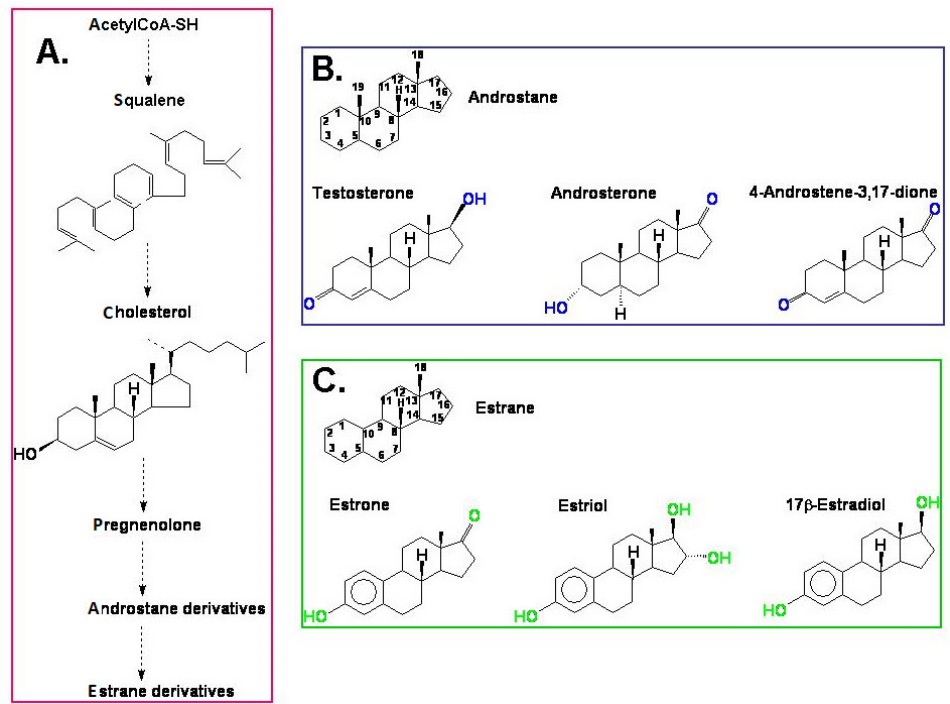
Figure 1. ( A ) A simplified model of the biosynthesis of steroid hormones (androstane and estrane derivatives) in animals and humans; ( B ) the chemical structure of androstane and selected androgens; ( C ) the chemical structure of estrane and the most important estrogens.